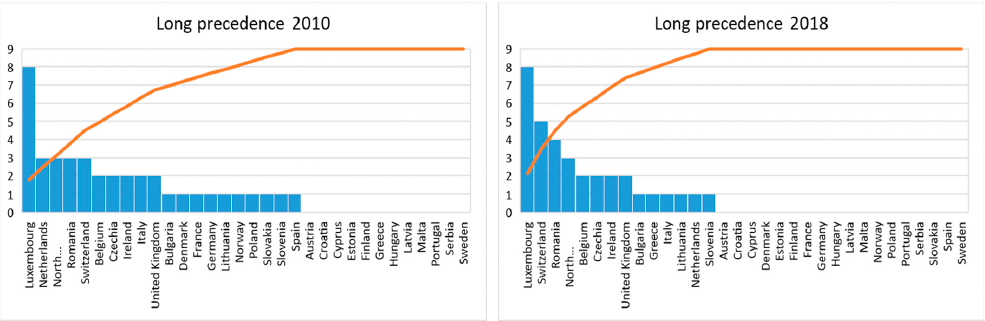
Figure 6. Number of the long precedencies by country in 2010 and 2018—geospatial